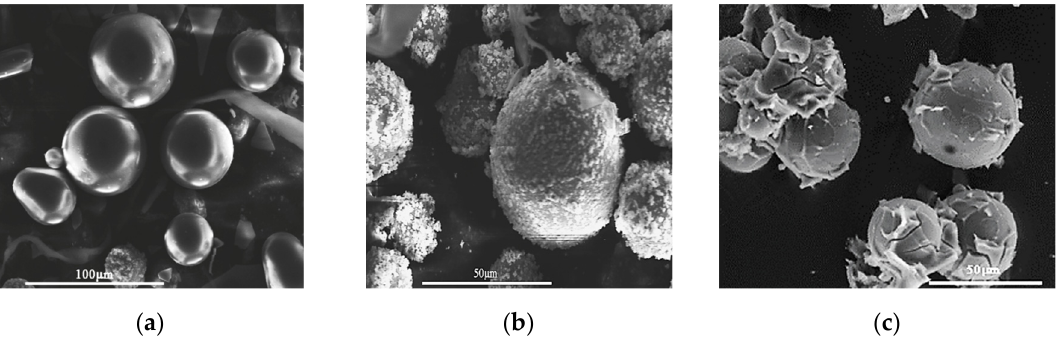
Figure 4. Scanning electron microscope (SEM) observation result for: ( a ) The core glass bead reference filler material, ( b ) the core-shell filler, and ( c ) the glass bead reference filler after silane treatment.